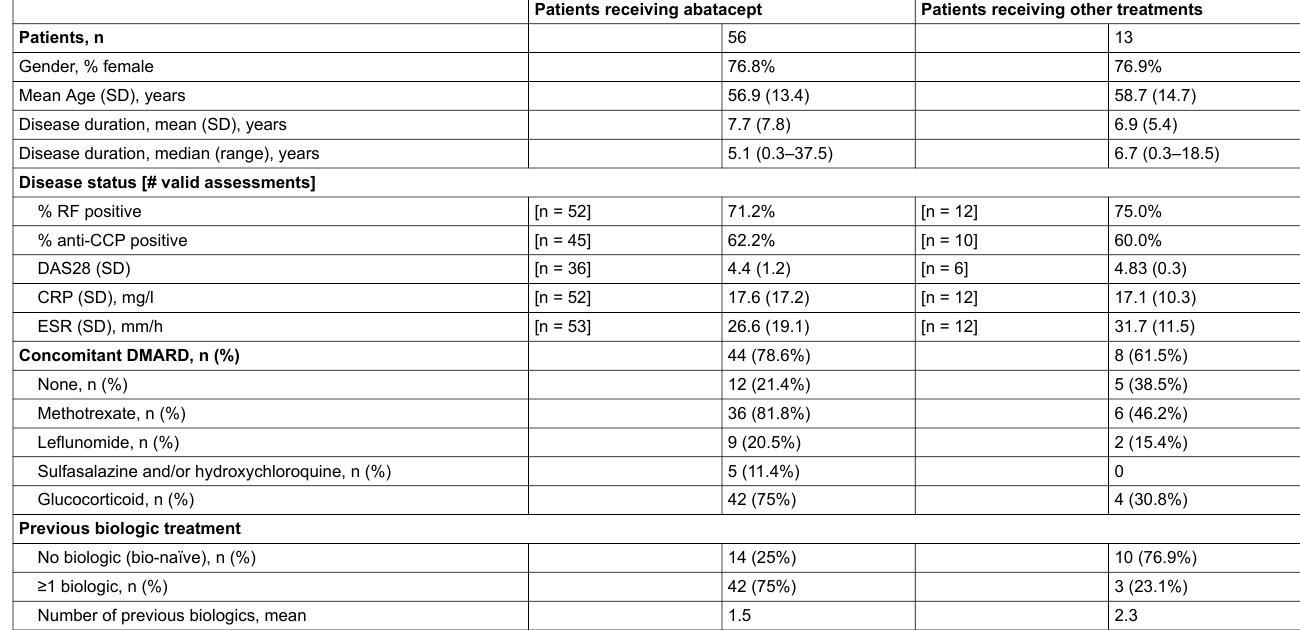
Table 1: Baseline characteristics of the study population. If not indicated otherwise, number of valid assessments for the abatacept and the “other treatments” group were 56 and 13, respectively. Patients receiving